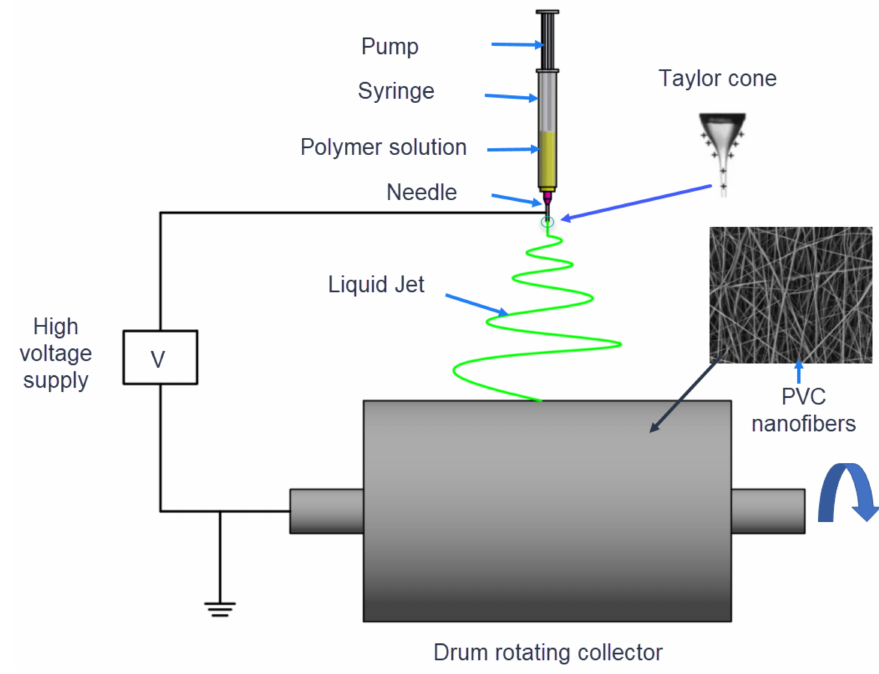
Figure 1. A schematic setup illustration for the electrospinning